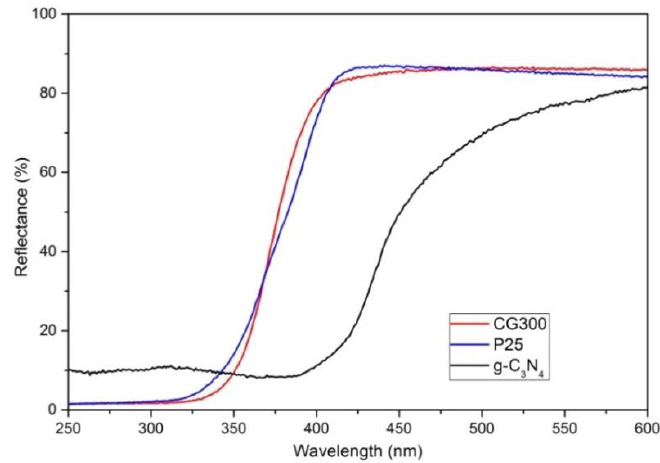
ff usion reflectance spectra of the tested Figure 1. Diffusion reflectance spectra of the tested nanomaterials. Figure 1. Di